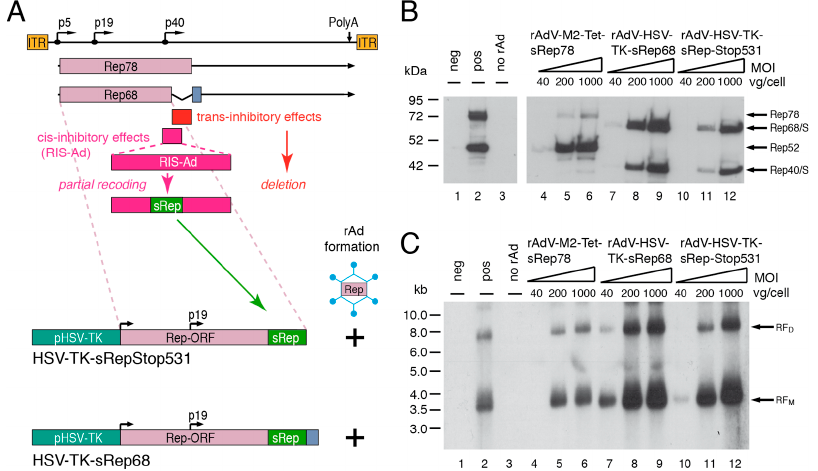
Figure 2. Improved rAdV-mediated expression of functional large Rep proteins by means of the constitutive HSV-TK promoter. ( A ) Genome organization of AAV-2 with a close-up of the RIS-Ad ( Rep inhibitory sequence for adenoviral replication ) in the 3 ′ -part of the rep gene (for further details compare Figure 1A) and depiction of the large Rep protein Rep68 and the truncated Rep-Stop531 protein, which terminates immediately after the major AAV-2 splice donor site. ( B ) Anti-Rep Western blot analysis after co-infection of HEK293 cells with purified rAAV-GFP vector (MOI 100) and either rAdV-M2-Tet-sRep, rAd-HSV-TK-sRep68 or rAd-HSV-TK-sRep-Stop531, as indicated, for 64 h. Positive control are pTR-UF5/pDG co-transfected cells. ( C ) Same experiment as in ( B ) with extraction of viral DNA and Southern blot analysis with a probe for the CMV-GFP transgene cassette. Arrows indicate monomeric and dimeric replicative rAAV-GFP DNA intermediates. Representative data from a total of three experiments is shown.